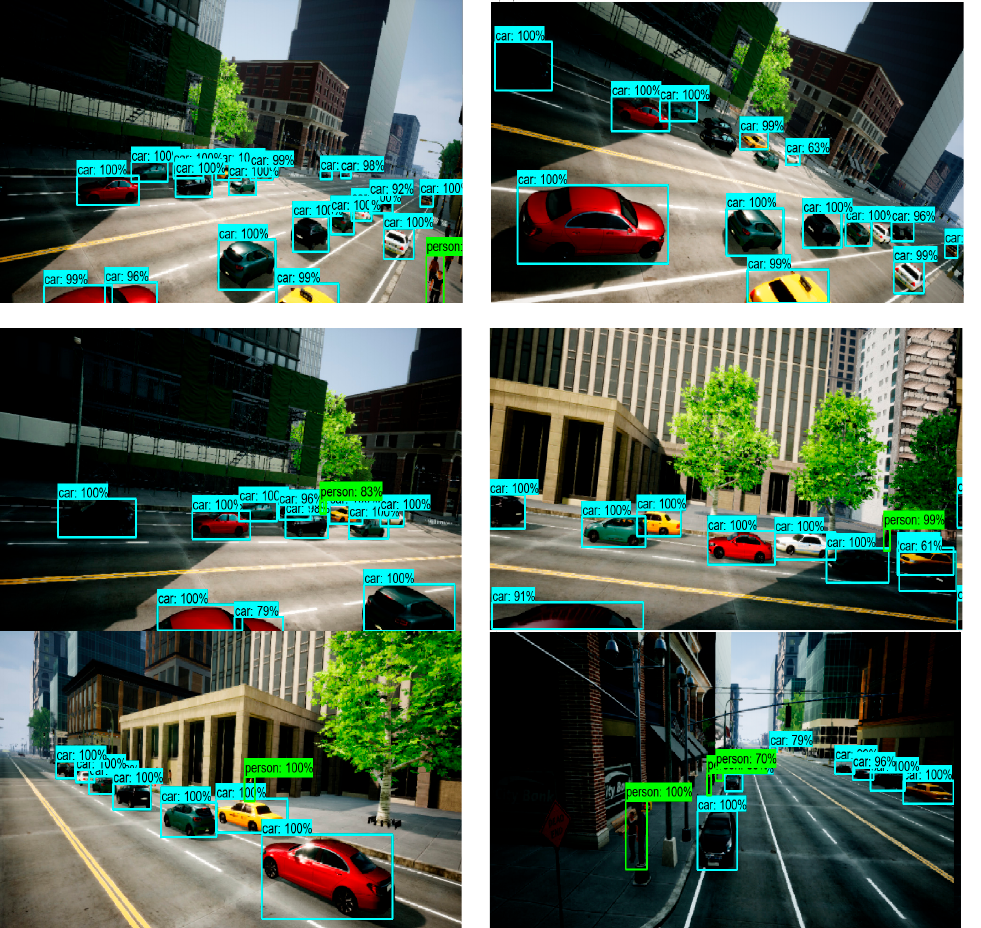
Figure 10. Qualitative results of the proposed tracking algorithm with two object classes: person and car.